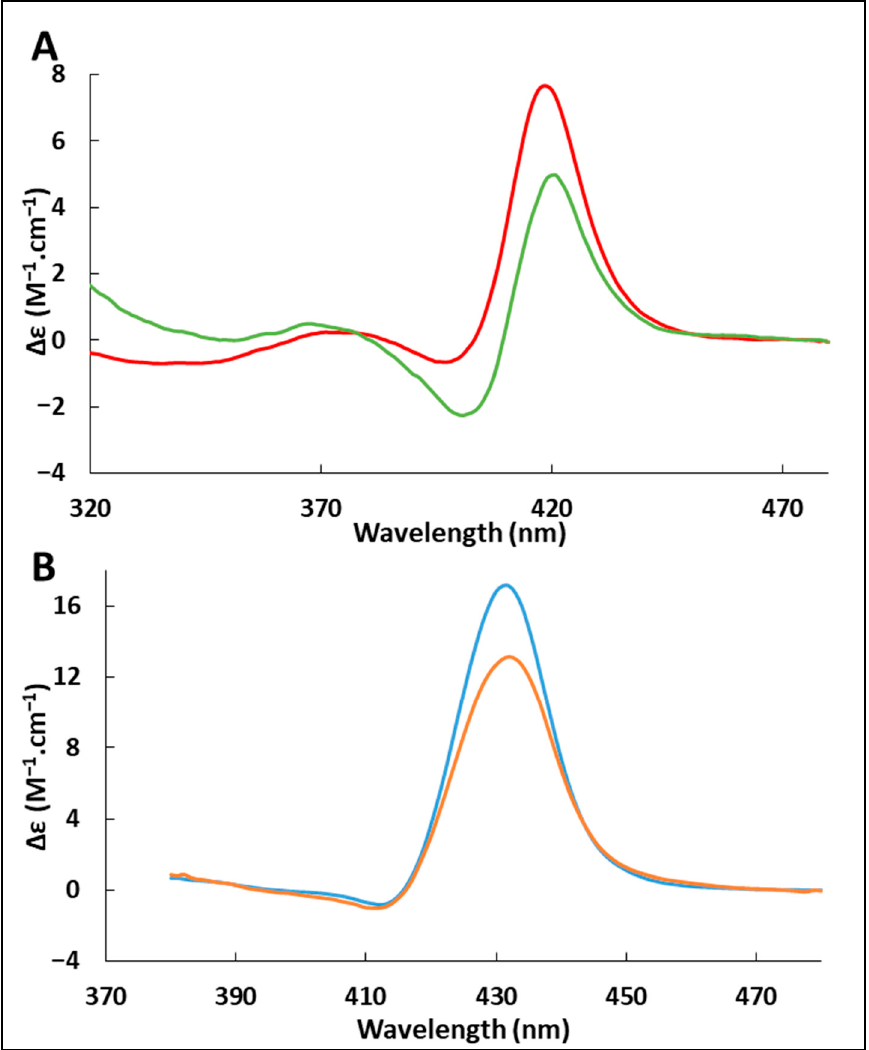
Figure 4. Circular dichroism spectra in the Soret region of ( A ) adsorbed (green line) and free (red line) oxygenated hemoglobin and ( B ) adsorbed (orange line) and free (blue line) deoxygenated hemoglobin. Data were recorded with 0.1 mM Hb in 0.1 mol.L − 1 phosphate pH 7.0 at 22 ◦ C for free oxyHb or free deoxyHb, and with 0.1 mM Hb and a NPs concentration of 10 g.L − 1 in 0.1 mol.L − 1 phosphate pH 7.0 at 22 ◦ C, 98% oxyHb or deoxyHb were